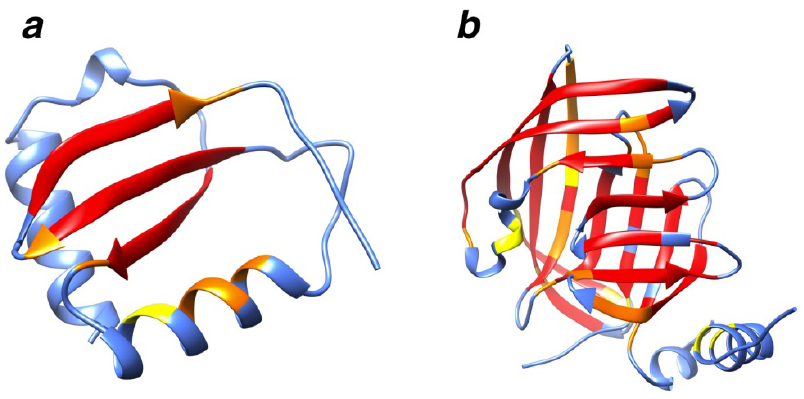
Figure 9. ( a ) Extent of coverage for 2dbs-A. In total, 17 residues of 2dbs-A (80 residues) are covered by 35 RSMs, leading to a coverage of 21.3% for the complete chain at backbone RMSD level 1 (red). At higher backbone RMSD levels, more RSMs cover 2dbs-A. At level 3, seven more residues are covered (orange), and at level 5, one additional residue is covered (yellow). The coverage increases to 30.0% and 31.3% at levels 3 and 5, respectively; ( b ) Extent of coverage for 2in5-A. In total, 81 residues of 2in5-A (195 residues) are covered by 82 RSMs, leading to a coverage of 41.5% for the complete chain at backbone RMSD level 1 (red). At higher backbone RMSD levels, more RSMs cover 2in5-A. At level 3, 22 more residues are covered (orange), and at level 5, seven additional residues are covered (yellow). The coverage increases to 52.8% and 56.4% at levels 3 and 5,